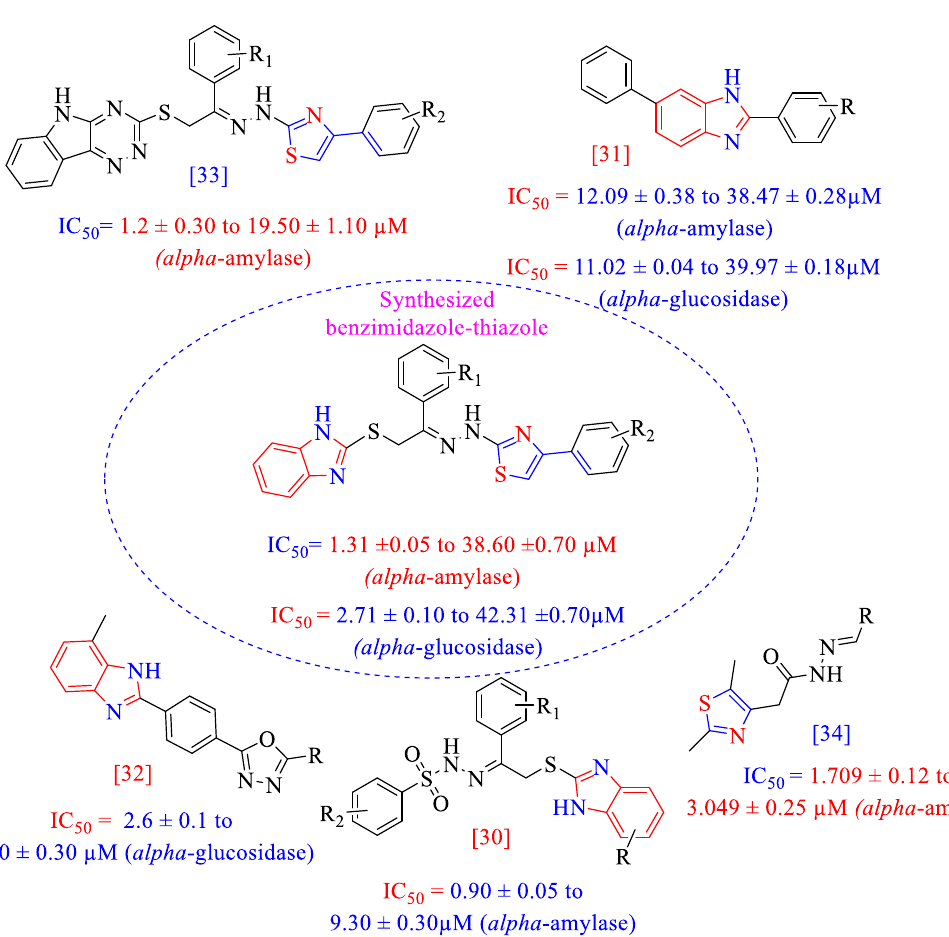
Figure 3. Rational of current